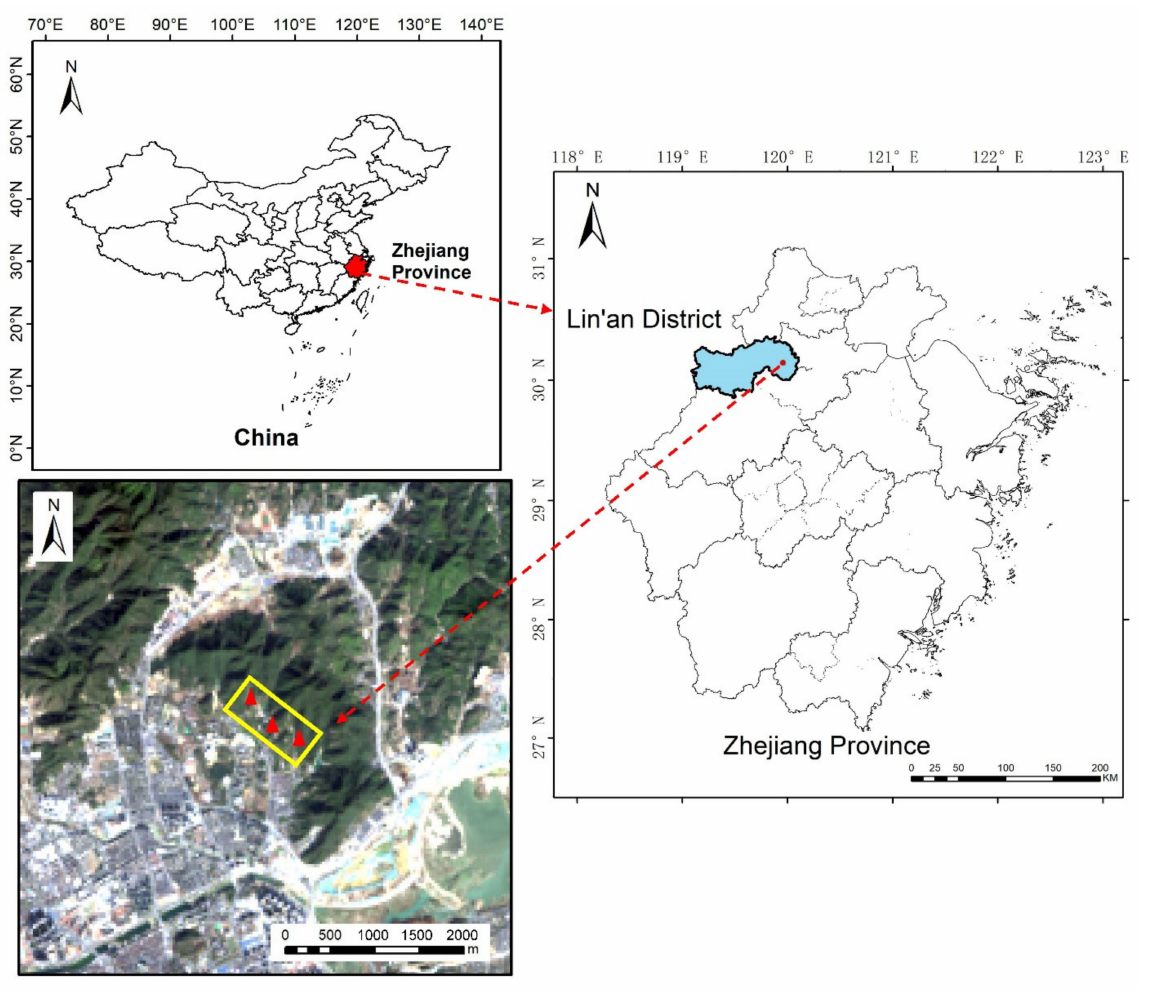
Figure 2. Test site location (yellow rectangle) and three sample plots (red triangles). The Landsat 8 image of 30 m resolution was acquired in December 2019 and was downloaded from the website of the U.S. Geological